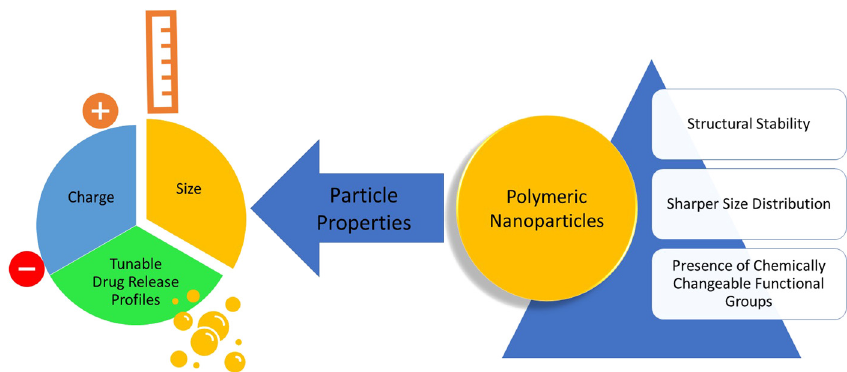
Figure 2: Physicochemical properties of